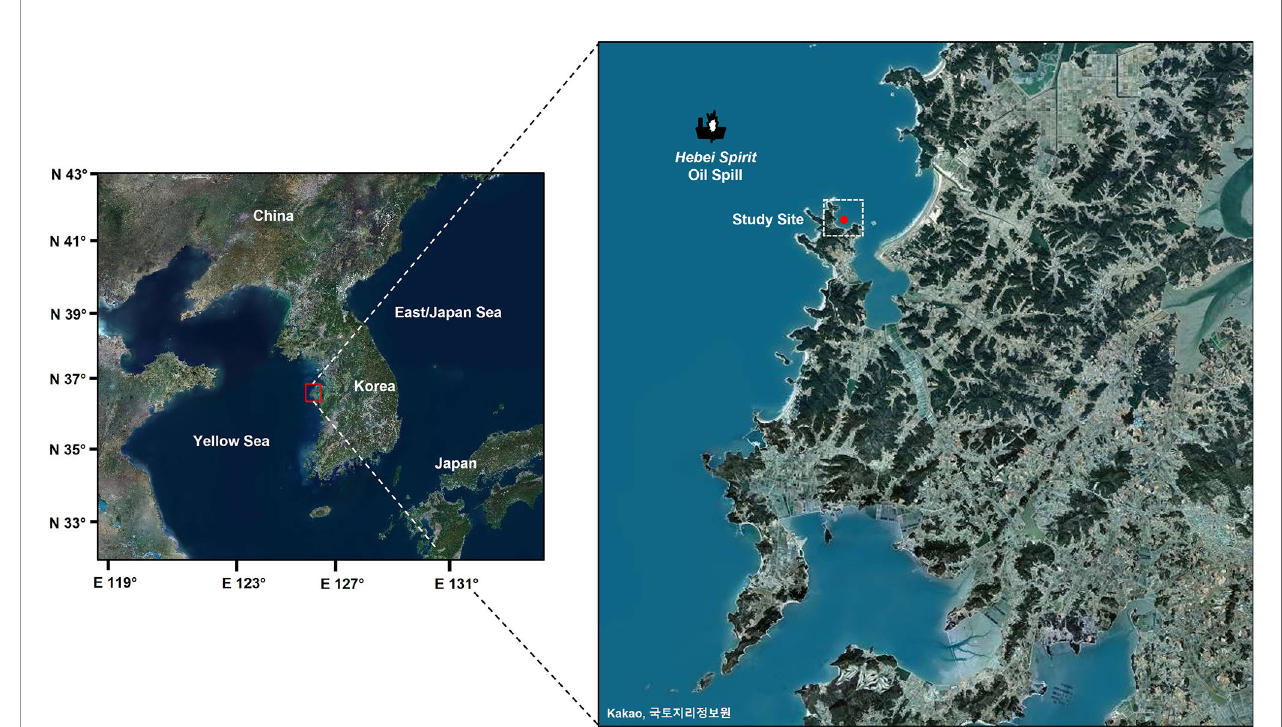
FIGURE 1 | Map showing the study site, Euhangri beach on the west coast of